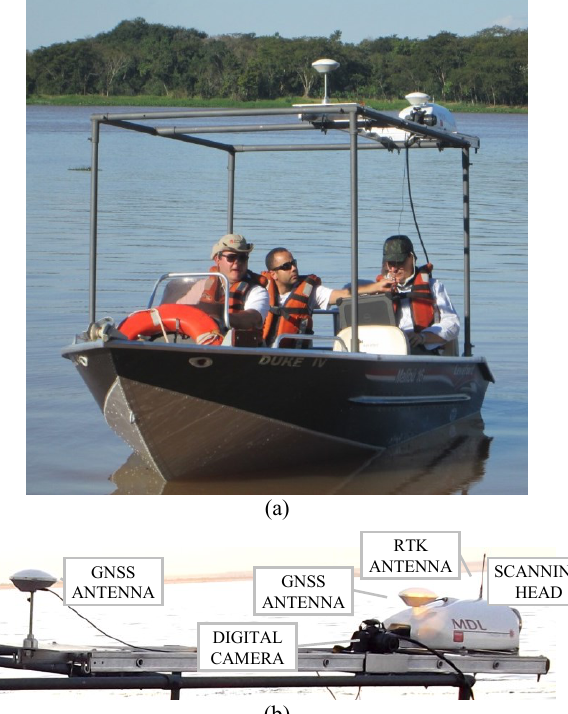
Figure 3. (a) Boat adapted and a Mobile Laser Scanner installed; (b) Details of the mount with the scanner